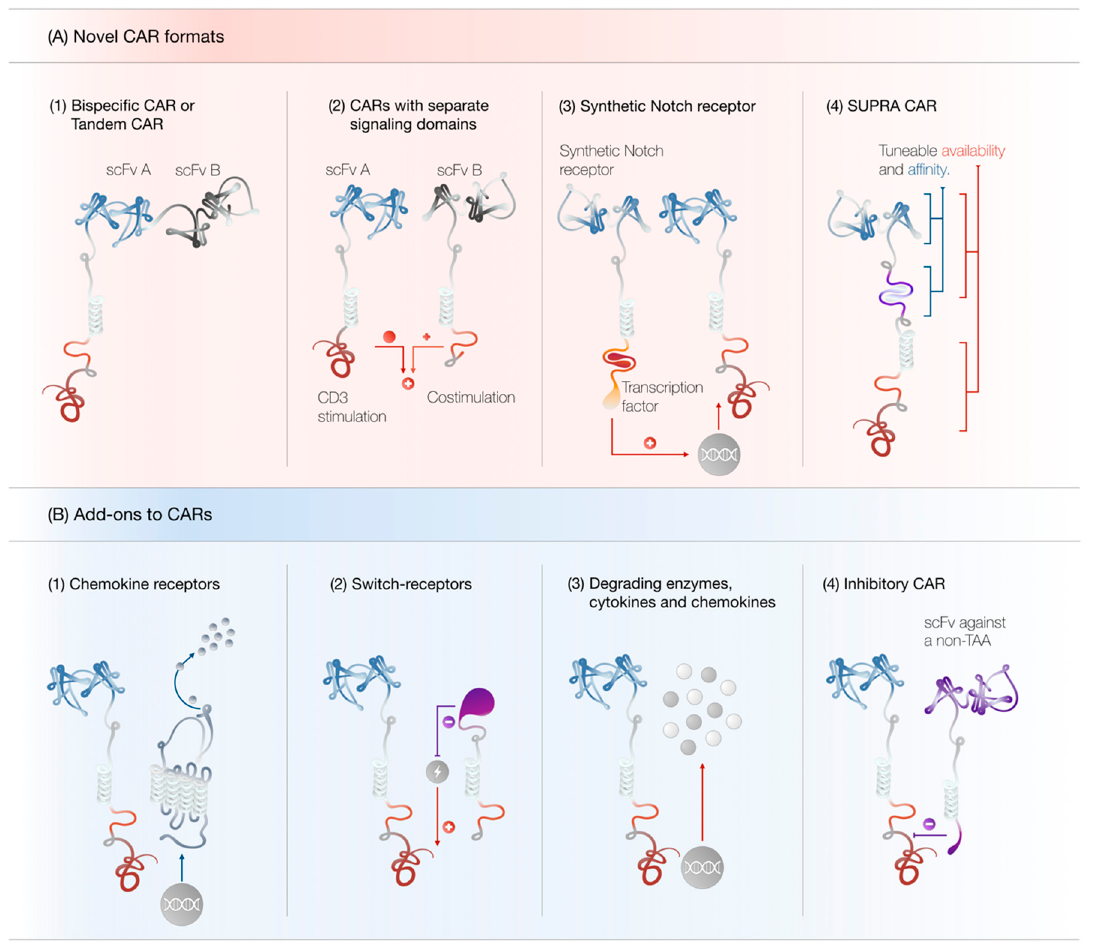
Figure 3. ( A ) Novel CAR formats. (1) Tandem CAR T cells can recognize either tumor antigen A or B and may prevent antigen escape. (2) CARs with separated signaling domains display attenuated off-tumor toxicity. (3) Synthetic Notch receptors can induce the transcription of another transgene, such as a conventional CAR, upon antigen recognition. (4) SUPRA CAR T cell activity may be tuned at multiple levels to ensure maximal effectiveness and minimal toxicity. ( B ) Add-ons to CARs. (1) CARs may be combined with chemokine receptors to increase CAR T cell trafficking to the tumor site. (2) Switch receptors can convert negative stimuli into positive ones. (3) CAR T cells can be engineered to secrete chemokines, cytokines and matrix-degrading enzymes to potentiate their anti-tumor efficacy. (4) Inhibitory CARs may be used to protect healthy tissue from CAR T cell-mediated destruction.